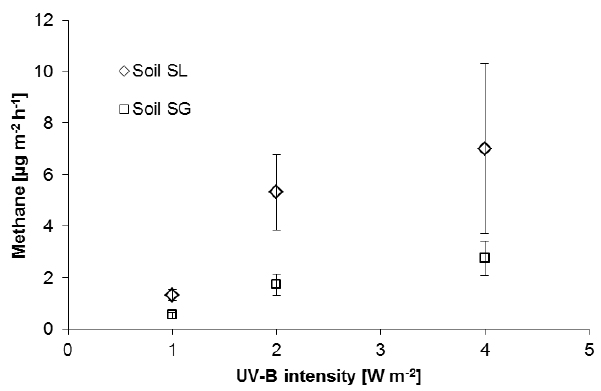
Fig. 5. Relationship between CH 4 emissions from soils SL and SG and UV-B intensity. Data show mean value ± SD ( n